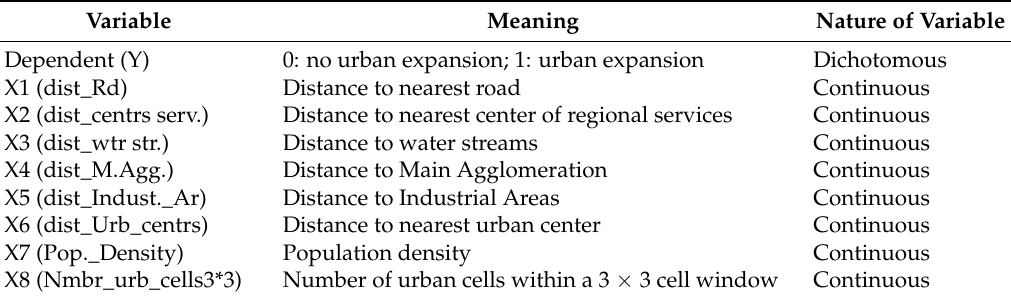
Table 3. List of factors (variables) included in the logistic regression model. Meaning Nature of